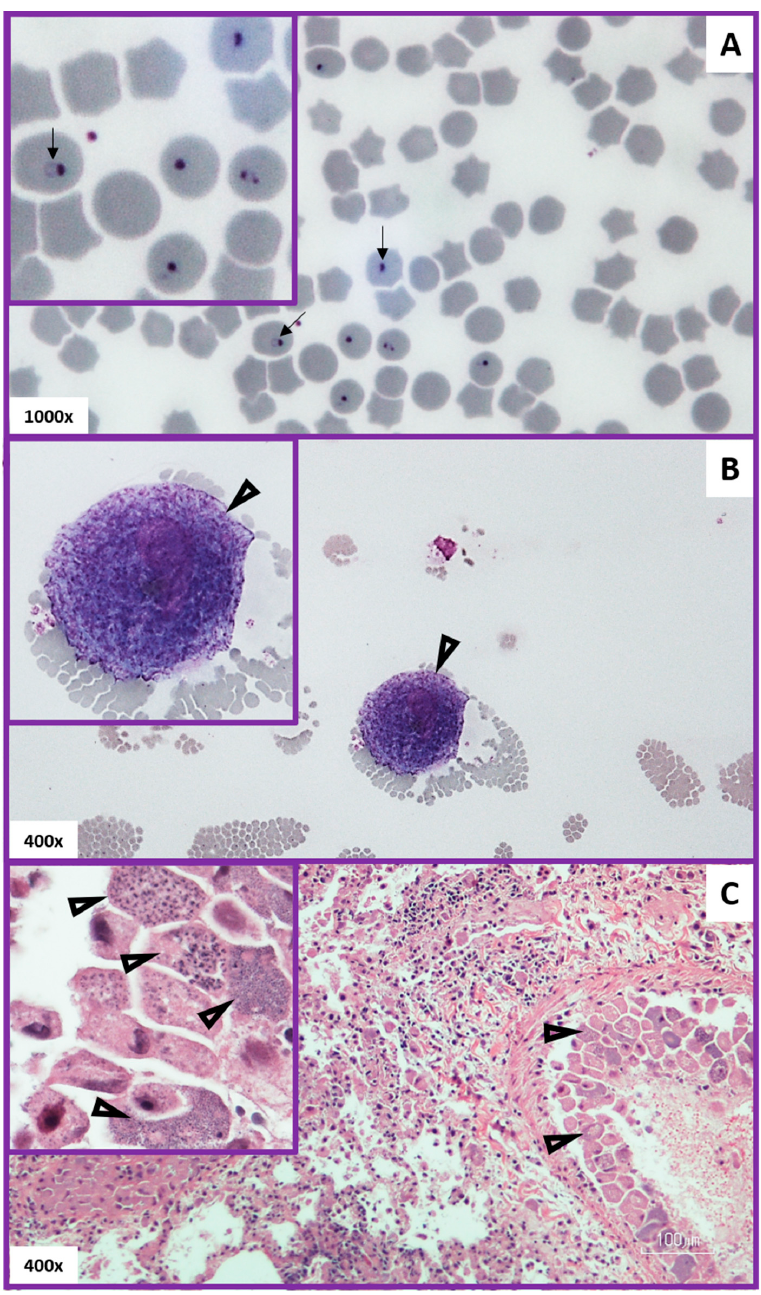
Figure 6. Diagnostic pathology of acute cytauxzoonosis. Panel ( A ) (top): Blood smear with intra-erythrocytic signet rings (arrows). Panel ( B ) (middle): Blood smear with a schizogenous monocyte (schizont) at the feathered edge (open arrowheads). Panel ( C ) (bottom): Histologic lung tissue with schizonts attached to endothelium (open arrowheads) within a vessel. Note the variable schizont developmental stages (arrows) seen in the Panel C inset.